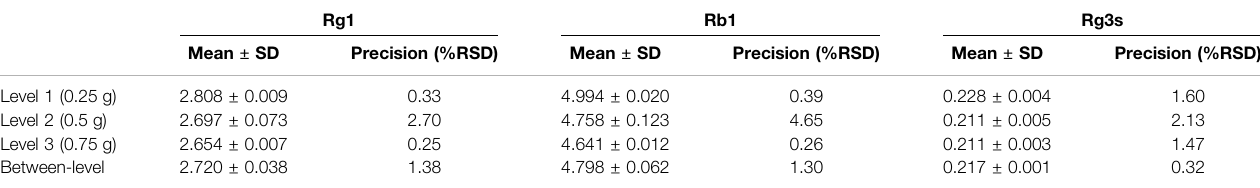
TABLE 1 | Precision of HPLC analysis.